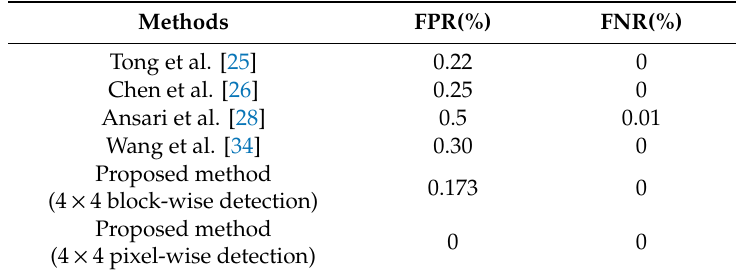
Table 6. False positive rate (FPR) and false negative rate (FNR) comparison of proposed methods and